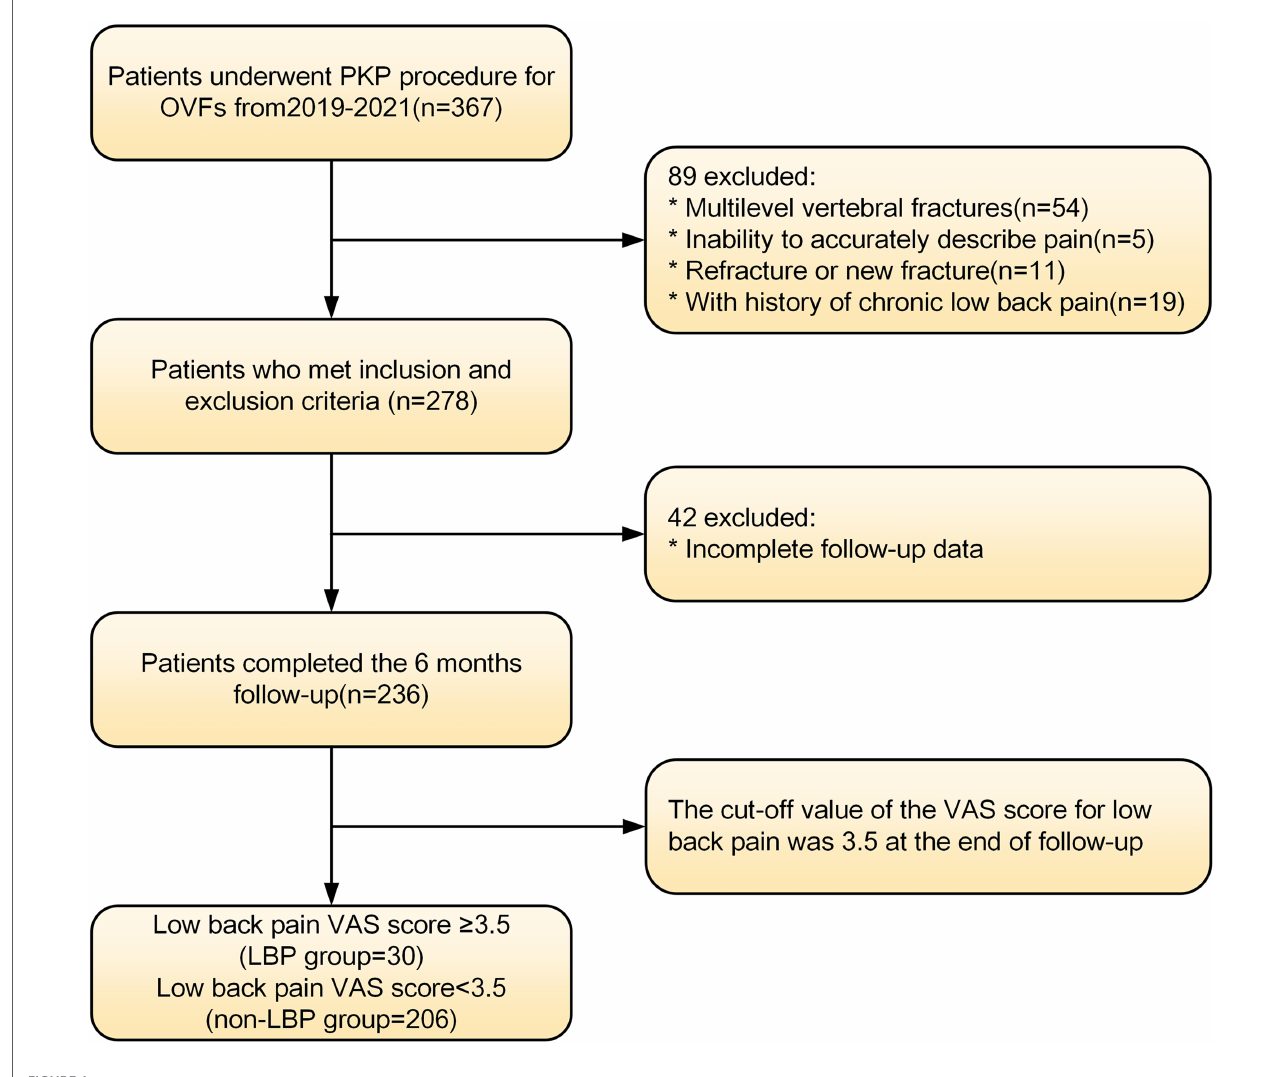
FIGURE 1 Patients selection fl